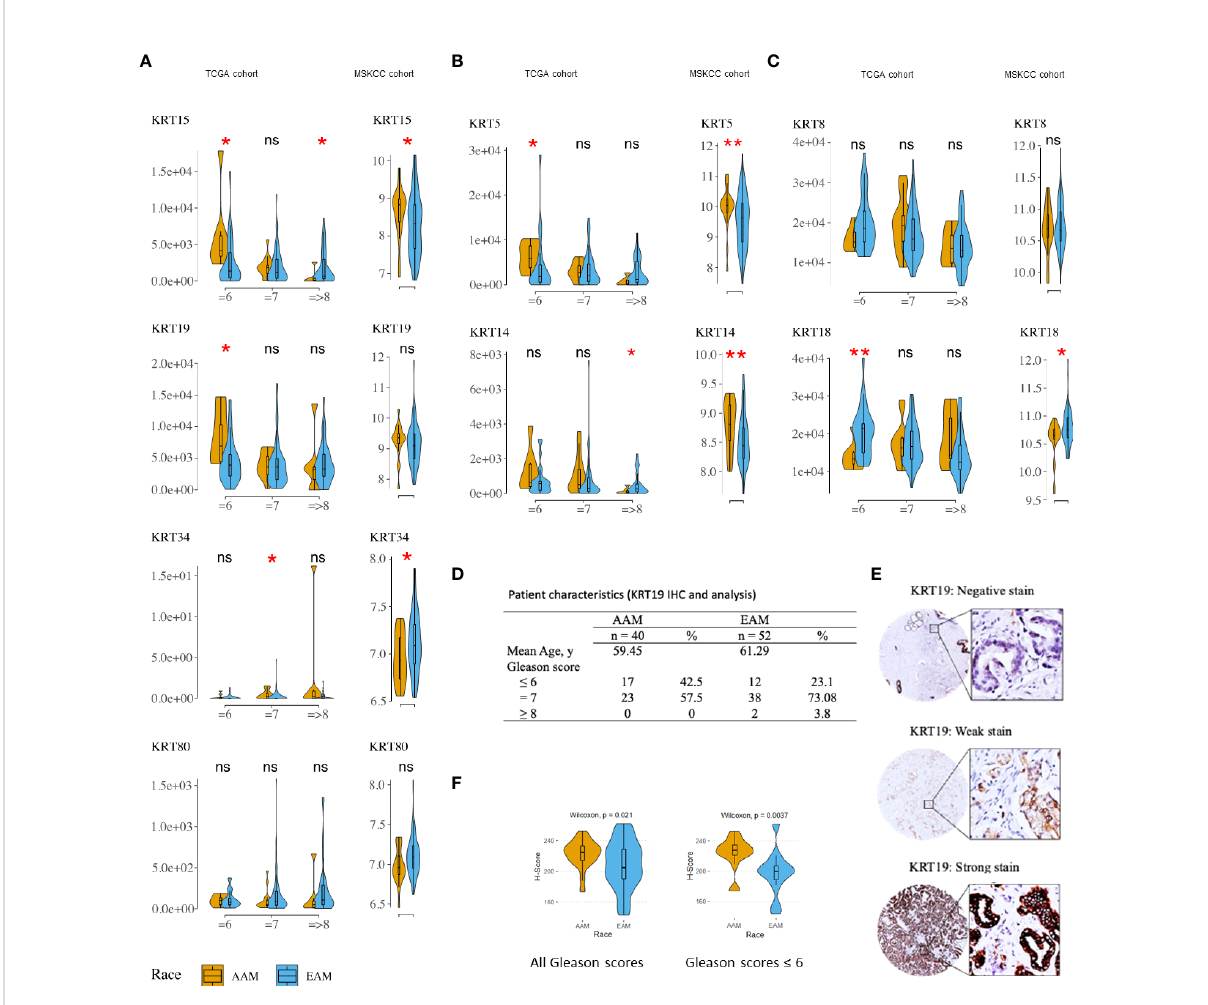
FIGURE 2 Distribution and median expression levels of keratins in AA and EA PCa patients (TCGA [ERG fusion negative] and MSKCC cohorts). (A) differentially expressed keratins (excluding KRT8 – see C) in the TCGA (left column) and MSKCC (right column) cohorts. (B) basal cell keratins ( KRT5 and KRT14 ). (C) luminal cell keratins ( KRT8 and KRT18 ). Statistically signi fi cant differences in gene expression were determined using the nonparametric Wilcoxon- Mann-Whitney test: *p ≤ 0.05; **P ≤ 0.01. TCGA patients were strati fi ed by Gleason (risk) categories; that is Gleason = 6 (low risk), Gleason = 7 (intermediate risk), and Gleason => 8 (high risk) categories. (D) Clinicopathological characteristics of prostate cancer patients in the deidenti fi ed prostate tumor cohort. (E) Immunohistochemical staining of KRT19 in prostate cancer tissues. Representative images of KRT19 negative, weak or strong staining. (F) boxplot of KRT19 H-Scores illustrating signi fi cant differences in AA Vs. EA prostate cancer patients. * P values < 0.05 were considered statistically signi fi cant. All the patients (upper panel) and patients with Gleason ≤ 6 (lower panel). ns, not signi fi